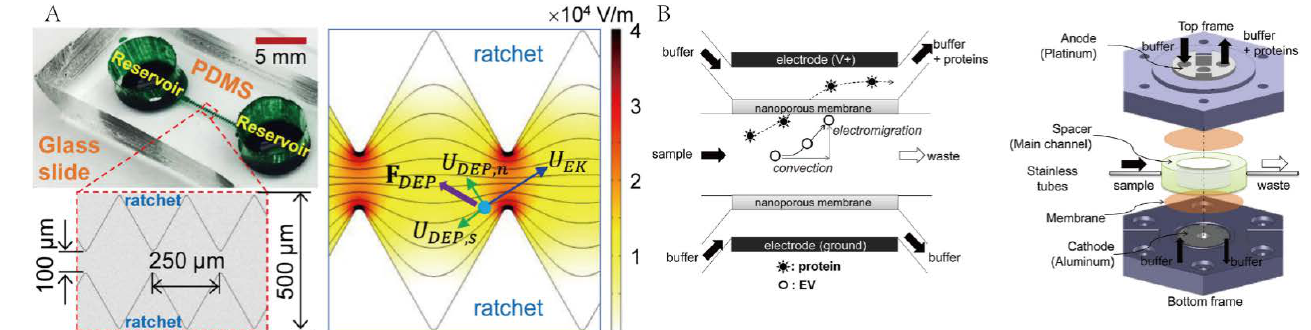
Figure 6. Microfluidic technology for exosome isolation based on the electrical field. ( A ) Schematic of microdevice used AC iDEP for exosomes isolation. Reprinted with permission [67] . ( B ) Schematic of isolation processes by electrophoretic migration. Reprinted with permission [55] .